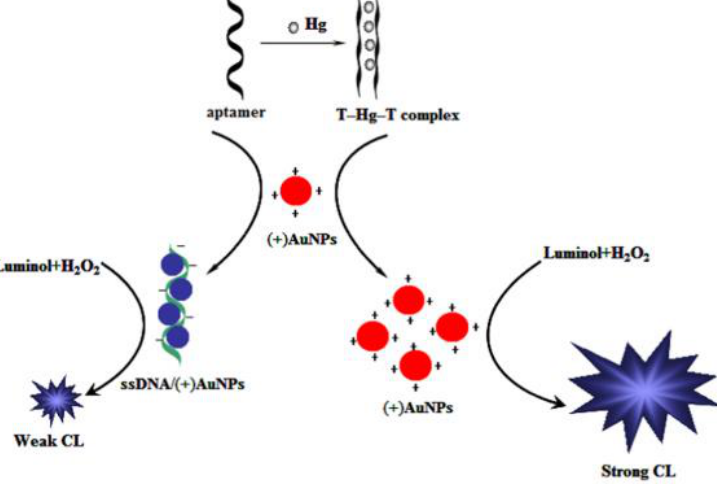
Figure 3. Metal ion-induced T–T complex mechanism for CL-based HM detection. Hg 2 + induces T–Hg 2 + –T complex formation preventing the interaction between aptamer and positive AuNPs, allowing the catalytic reaction occurrence and a stronger CL signal emission. From ref. [38], with the permission of the Publisher.